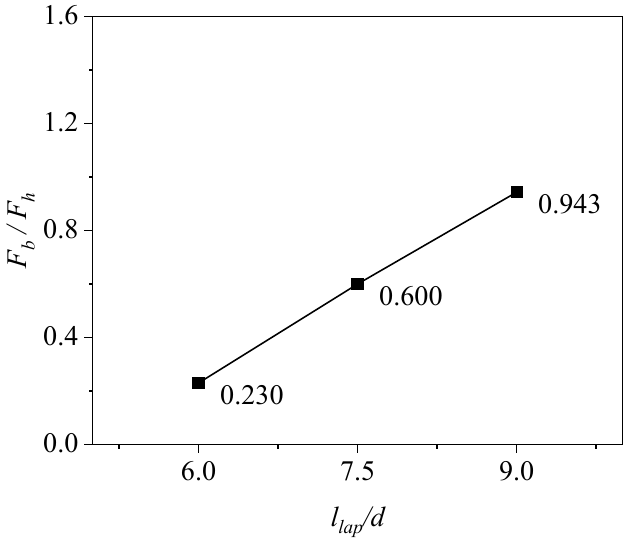
Figure 18. Relationship between F b /F h and lap length.